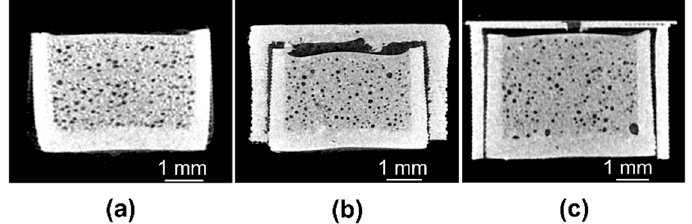
Figure 5. Computed microtomographs of longitudinal sections through the midline of: ( a ) MV1; ( b ) MV2; ( c ) MV3 with 0.4 mm orifice.